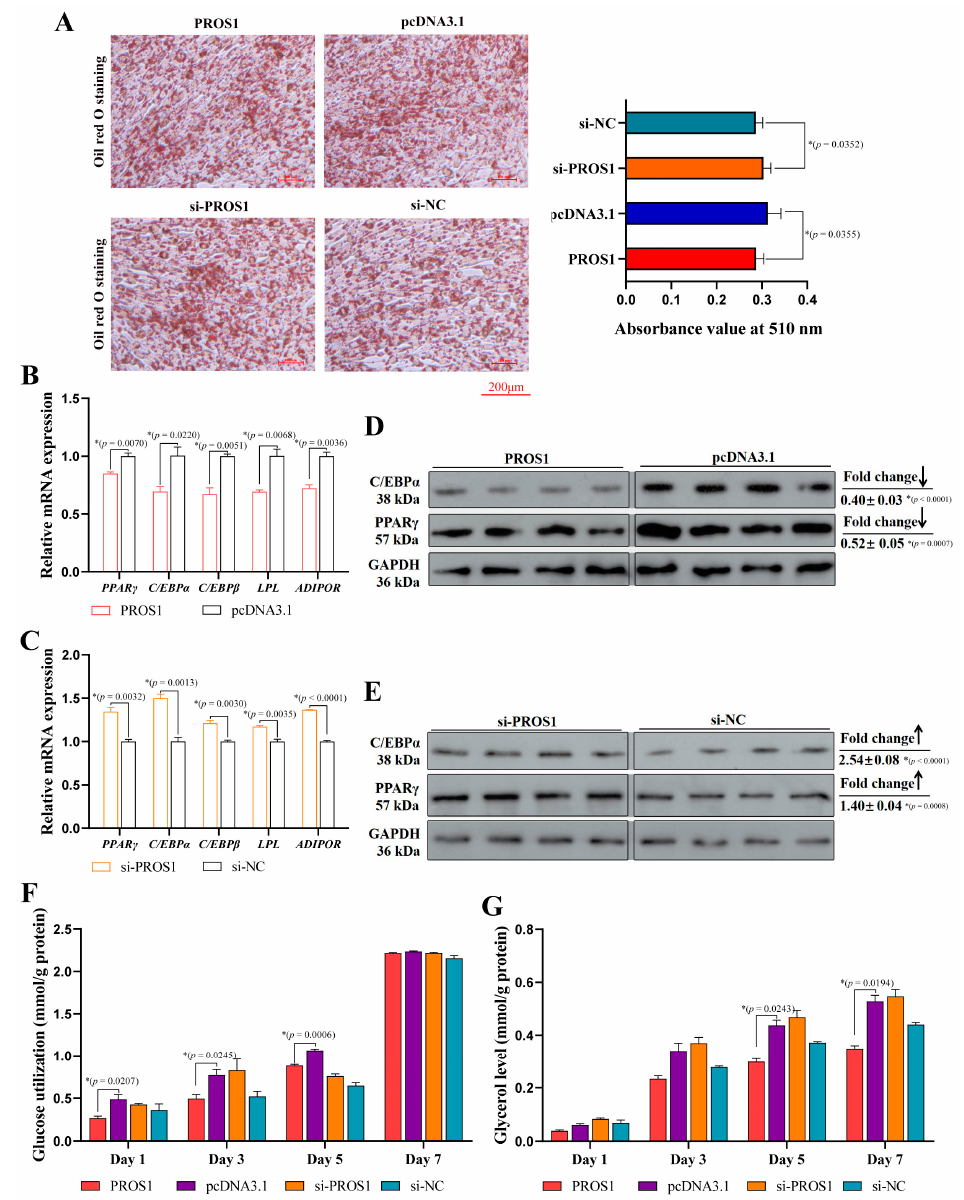
Figure 3. PROS1 inhibits chicken preadipocyte differentiation. ( A ) The oil red O staining and statistics of ICP-1 after treating with pcDNA.1- PROS1 plasmid and si- PROS1 . ( B , C ) The mRNA levels of preadipocyte differentiation-related genes in ICP-1 treated with PROS1 overexpression and knockdown were detected by qRT-PCR. ( D , E ) The protein levels of CEBP α and PPAR γ in ICP-1 treated with PROS1 overexpression and knockdown were detected by Western blot. ( F ) The glucose consumption measure during ICP-1 differentiation. ( G ) The glycerol production measure during ICP-1 differentiation. The results are all presented as means ± SEM, * p < 0.05. Original western blot figures in Figure S1.